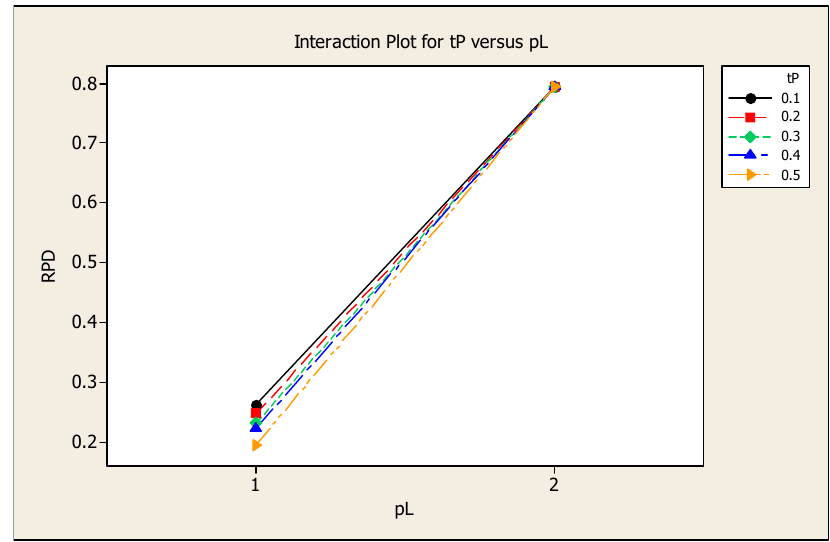
Figure 5. Interaction plot for 𝑡𝑃 versus 𝑝𝐿 .